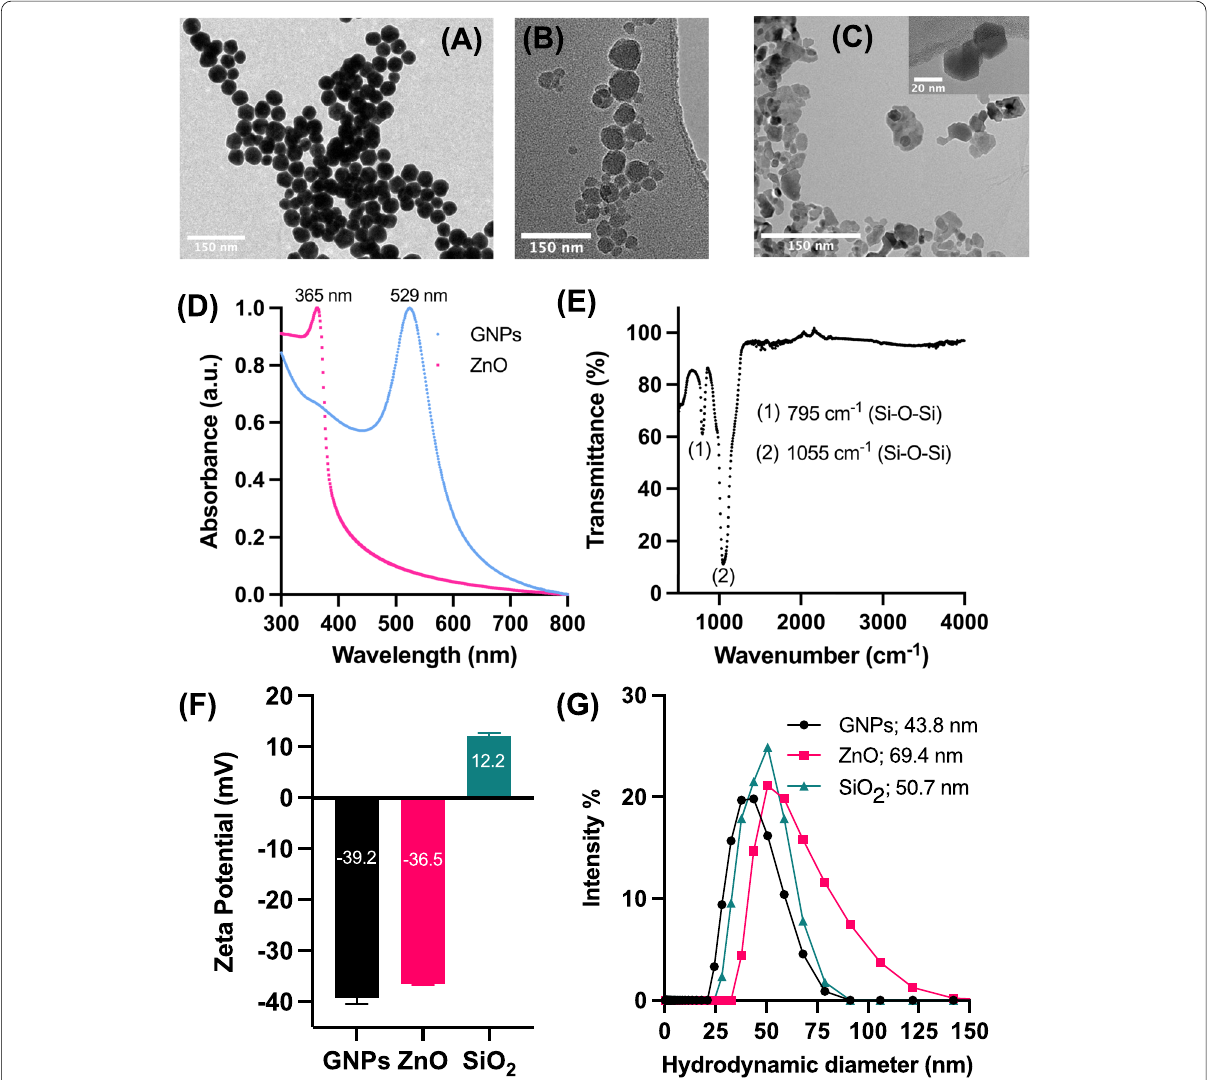
Fig. 1 Physico-chemical characterization of inorganic NPs (Gold – GNPs; Zinc Oxide – ZnO; Silica oxide – SiO 2 ). Transmission electron microscopy images of ( A ) GNPs, ( B ) SiO 2 and ( C ) ZnO NPs. D UV-Vis absorption spectrum of ZnO and GNPs in PBS; E FTIR spectrum of SiO 2 NPs; F Zeta potential; and G Hydrodynamic diameter obtained using DLS. Error bars represent the standard deviation of the mean n